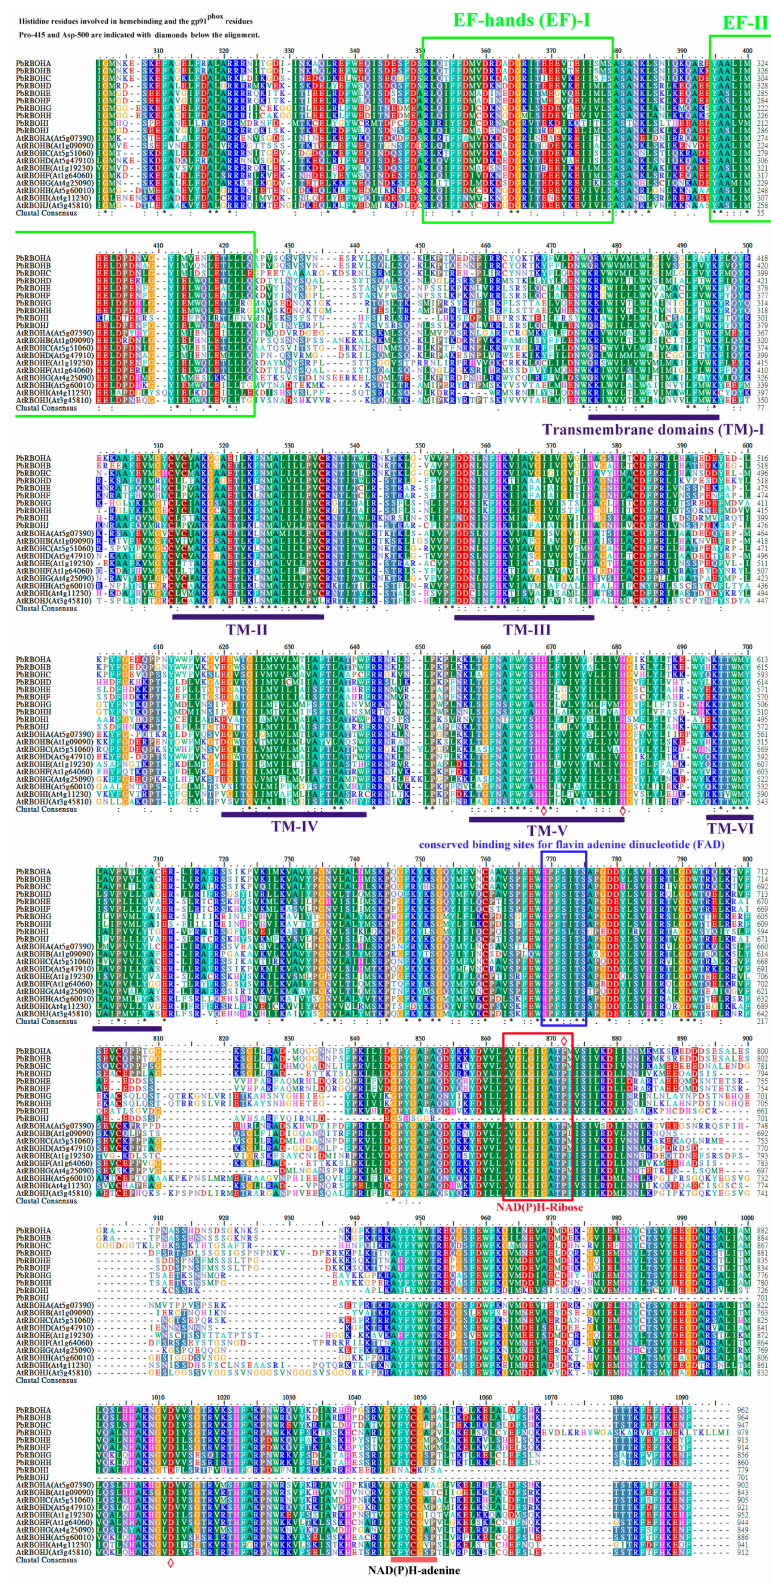
Figure 4. Protein sequence multi-alignment and domain structure of RBOHs from pear and Arabidopsis . Conservative residues are highlighted by black asterisks. Histidine residues involved in heme binding and the gp91 phox residues Pro-415 and Asp-500 are indicated with diamonds. EF-hands and conserved binding sites for FAD, NAD(P)H-adenine, and NAD(P)H-ribose are represented by straight lines or boxes. Transmembrane domains are indicated by straight